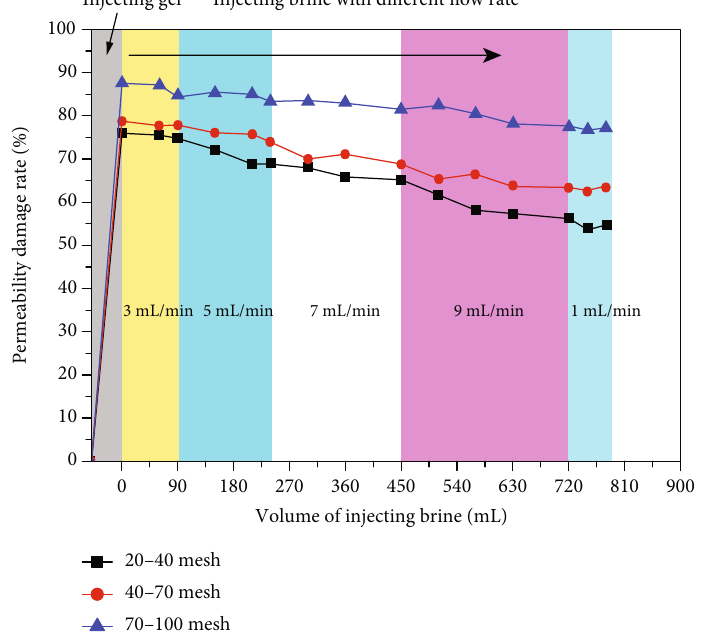
Figure 5: In fl uence of proppant particle size on damage rate of coal sample permeability.